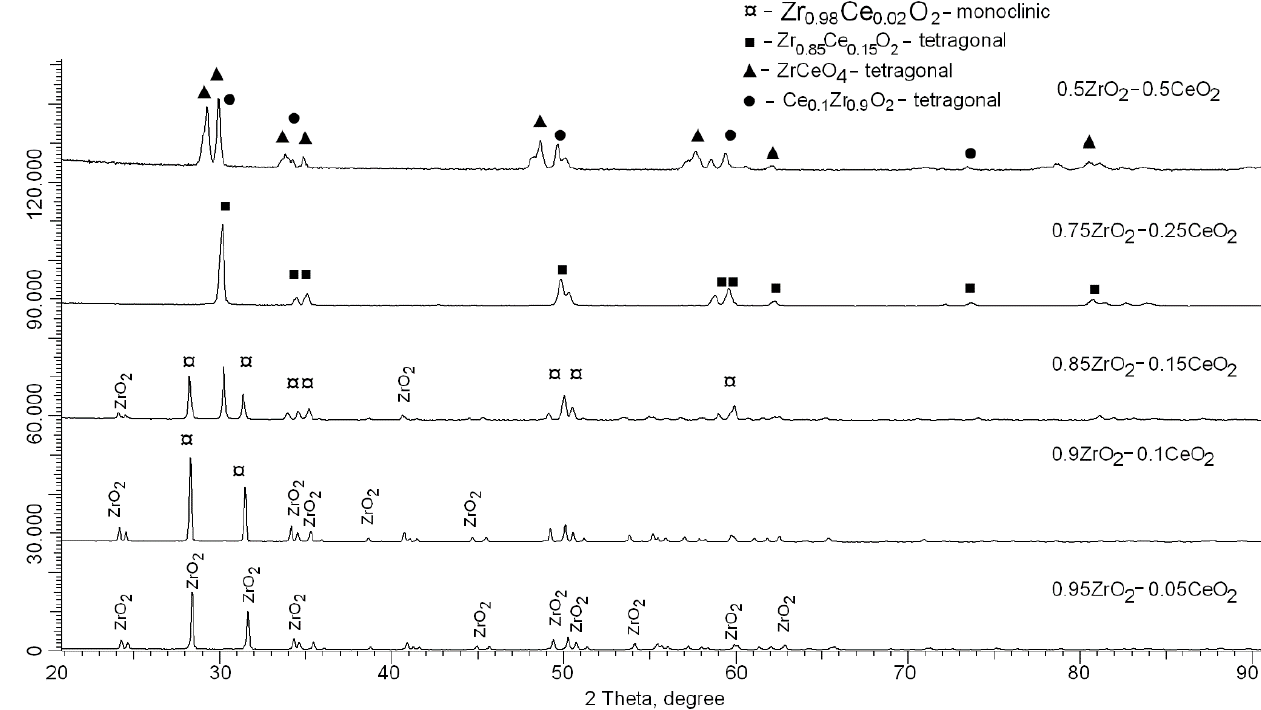
Figure 2. X-ray diffraction patterns of the studied samples depending on the content of the com-